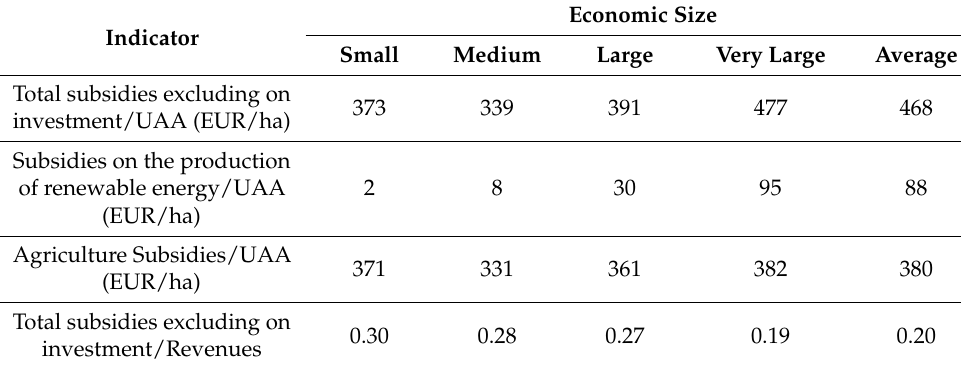
Table 12. Subsidies level (2015–2020